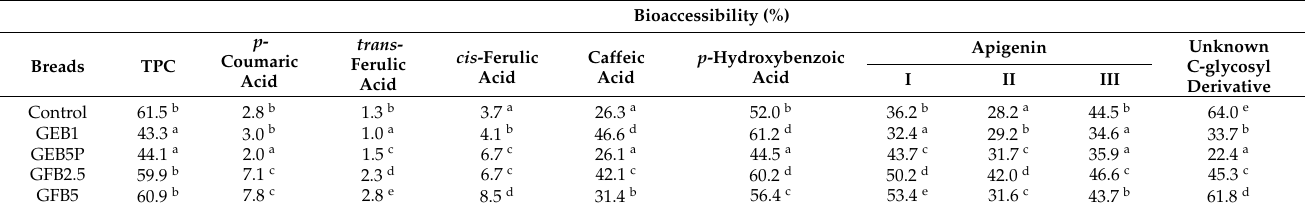
Table 4. Percentage of bioaccessibility of total phenolic content (TPC) and individual phenolics from control and bioprocessed breads after in vitro